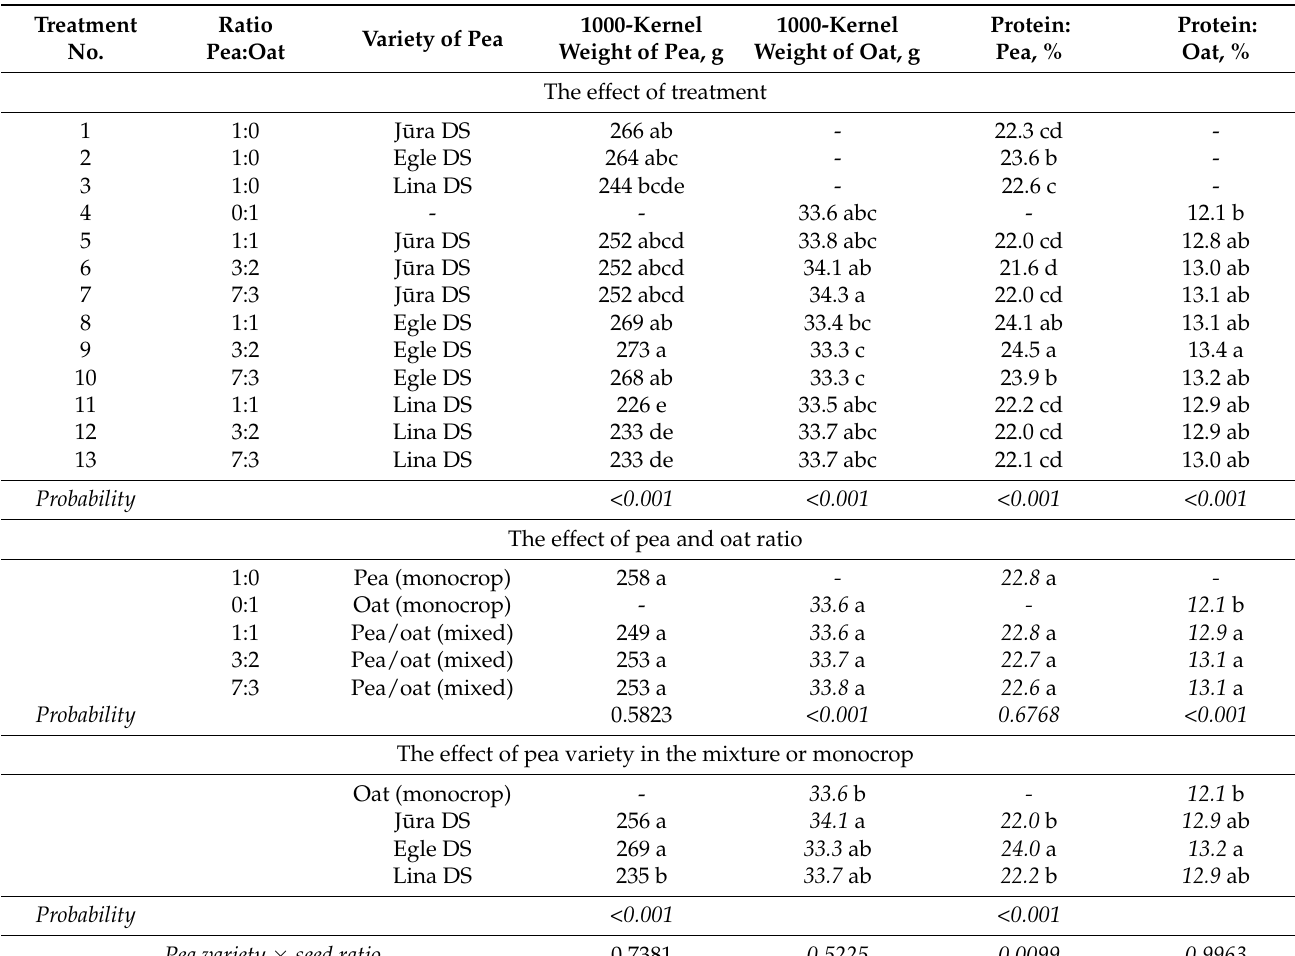
Table 1. The crops’ 1000-kernel weights and protein content in the grains, averaged over the three years, depending on the pea sowing rate and the different